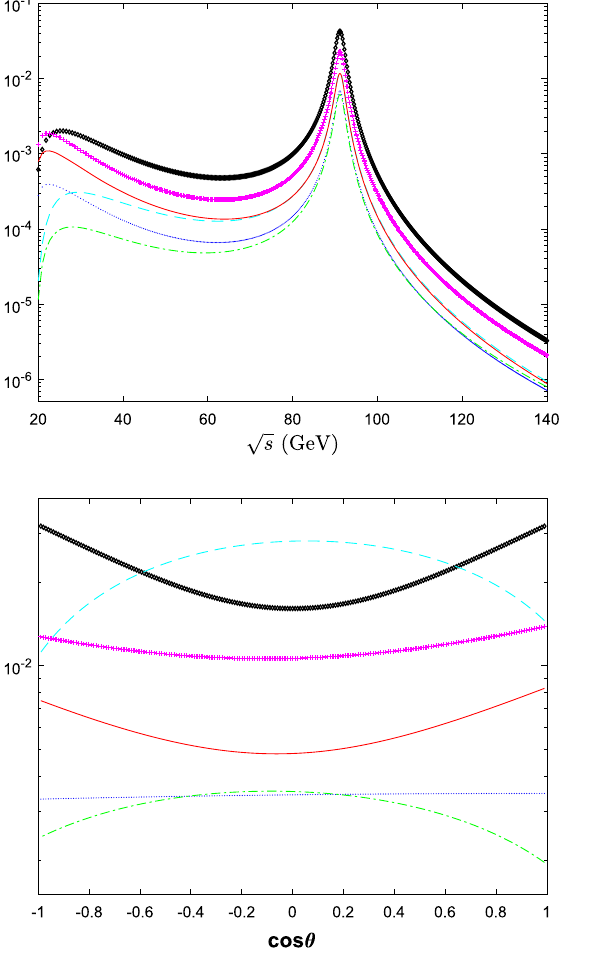
√ s and the renor- line, solid red line, dotted blue line, and the dash-dotted green line are for the top six Z 0 propagated channels in Table 2: η b + ϒ , ϒ + χ b 2 , √ ϒ + ϒ , ϒ + χ ϒ + χ ϒ + h s = m Z for the double bottomonium b 1 , b 0 , and b ,